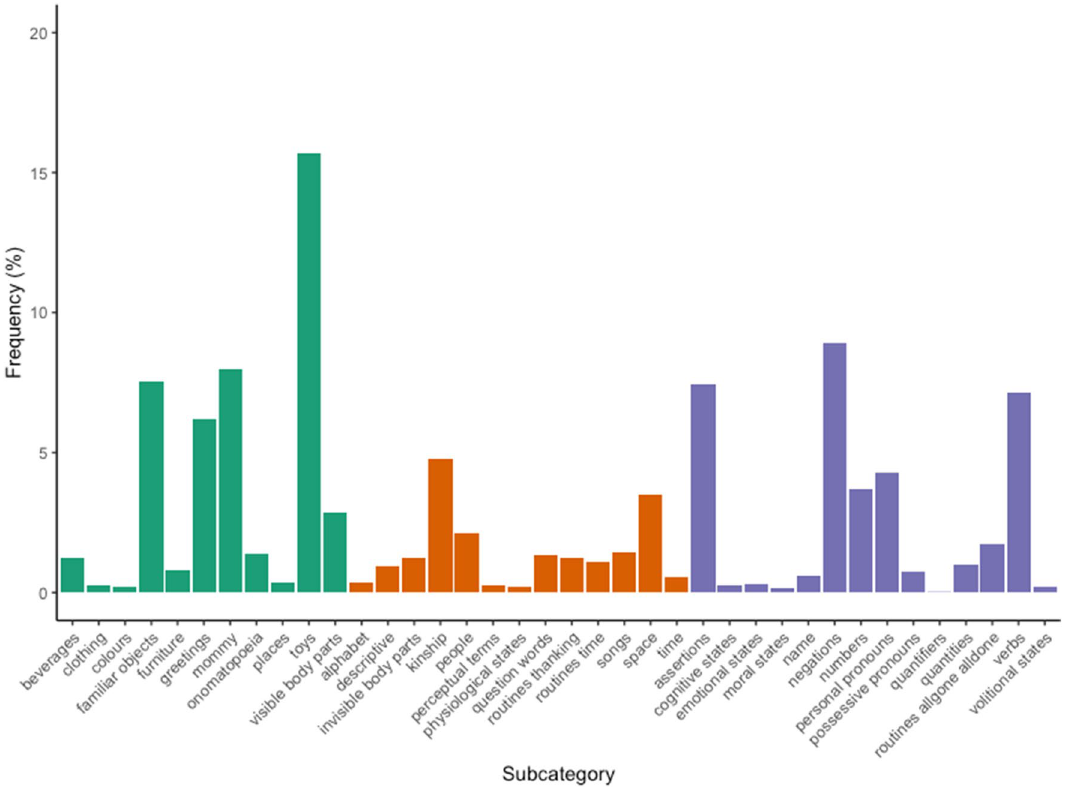
Figure 1. Percentage of words produced by children across age groups for all subcategories. Green bars represent concrete subcategories, orange bars represent subcategories with an intermediate level of abstractness, blue bars represent abstract